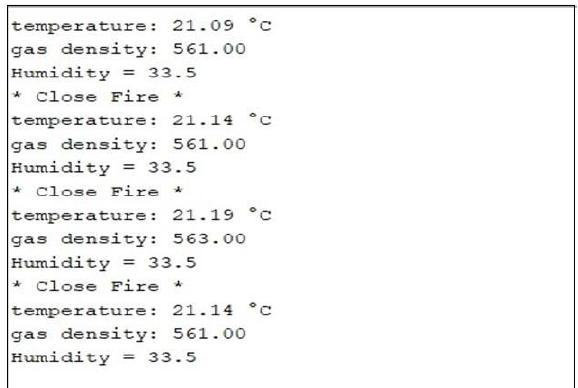
Fig. 7 : Result of Monitoring System